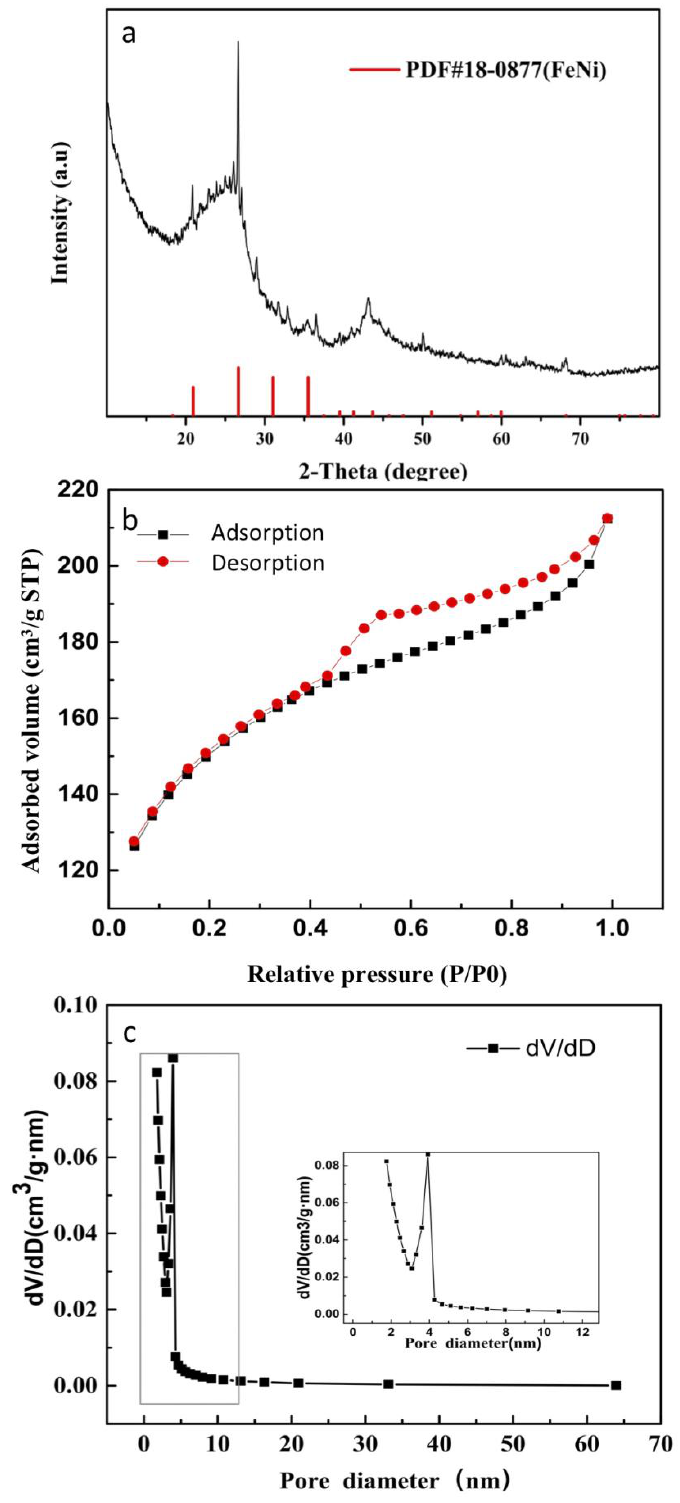
Figure 2. XRD pattern ( a ), nitrogen adsorption–desorption isotherms ( b ) and pore size distribution of / MAC ( c the fresh Fe-Ni/MAC ( c ). the fresh Fe-Ni